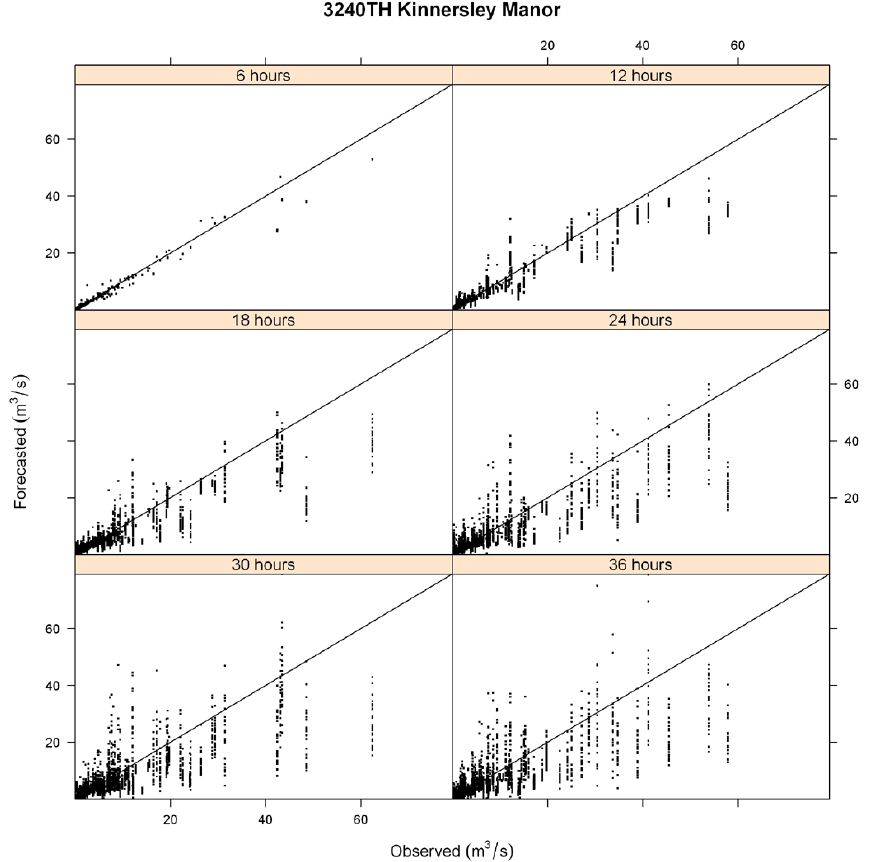
Fig. 3. Scatter plot of forecast and observed flow for different lead-times for Kinnersley Manor. Table 2. Mean RPS for the period July 2008 to February 2009 using the thresholds listed in Table 1. Lead Time Colindeep Marsh Redbridge Addlestone Binfield Kinnersley Newbury in hours Lane Farm 5480TH 2989TH 2250TH Manor